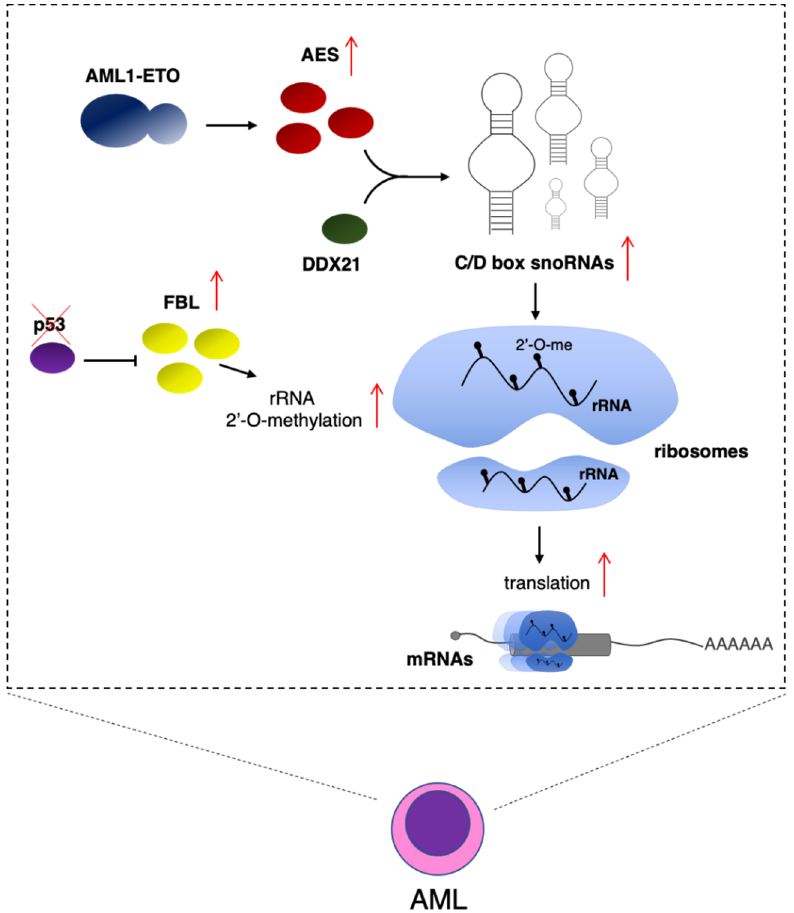
Figure 2. rRNA 2 ′ -O-me levels regulate translation in AML cells. Expression of AML1-ETO in AML cells results in increased AES expression. AES interacts with the DDX21 RNA helicase to induce C/D box snoRNA levels. Mutation in TP53 , which encodes for the p53 onco-suppressor , produces increased FBL levels. In both cases, this results in high levels of rRNA 2 ′ -O-me and increased protein translation [39,43].